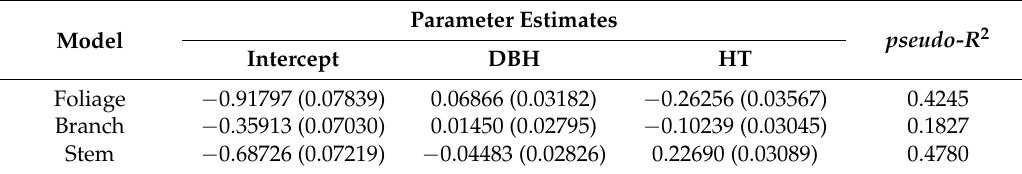
Table 3. Parameter estimates, their standard error (in parenthesis), and pseudo-R 2 (an R 2 -like measure calculated based on estimated likelihood) values for the small DBH trees using beta regression.